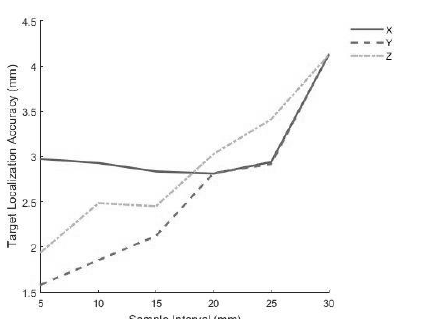
Figure 9. Relationship between the sample intervals and the accuracy of target localization using the presented method In comparison with Cyclone, the presented method can localize all the targets when the sample interval exceeds